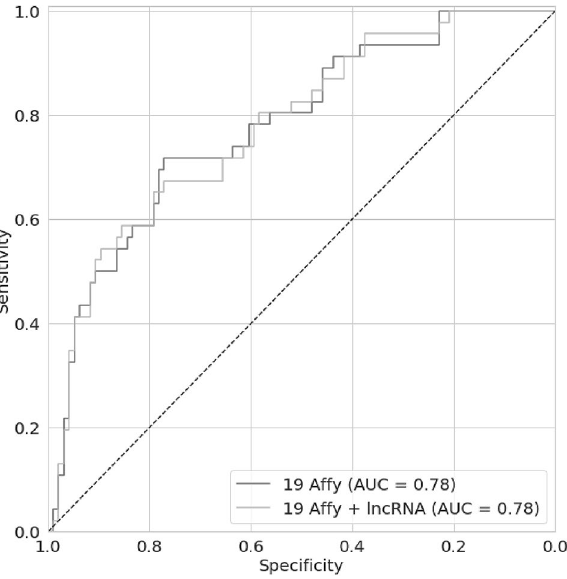
Figure 3. Receiver operating characteristic (ROC) curves for Random Forest feature selection. AUC, Area Under Curve.